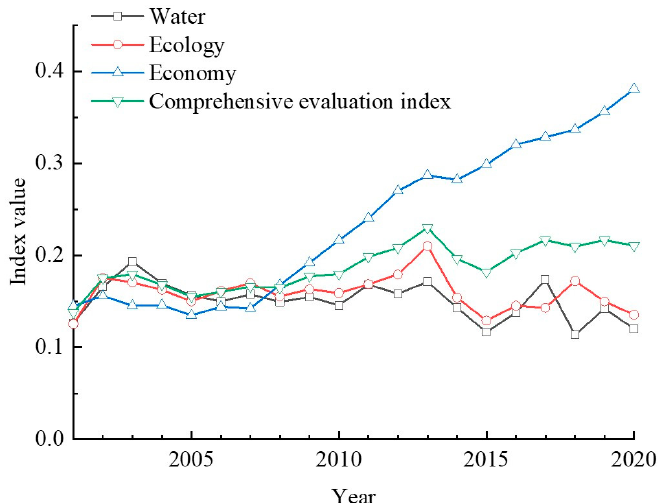
Figure 2. Interannual change trends in water, ecology and economy subsystem evaluation indices and their comprehensive index, respectively, in the Wuding River watershed from 2001 to 2020.